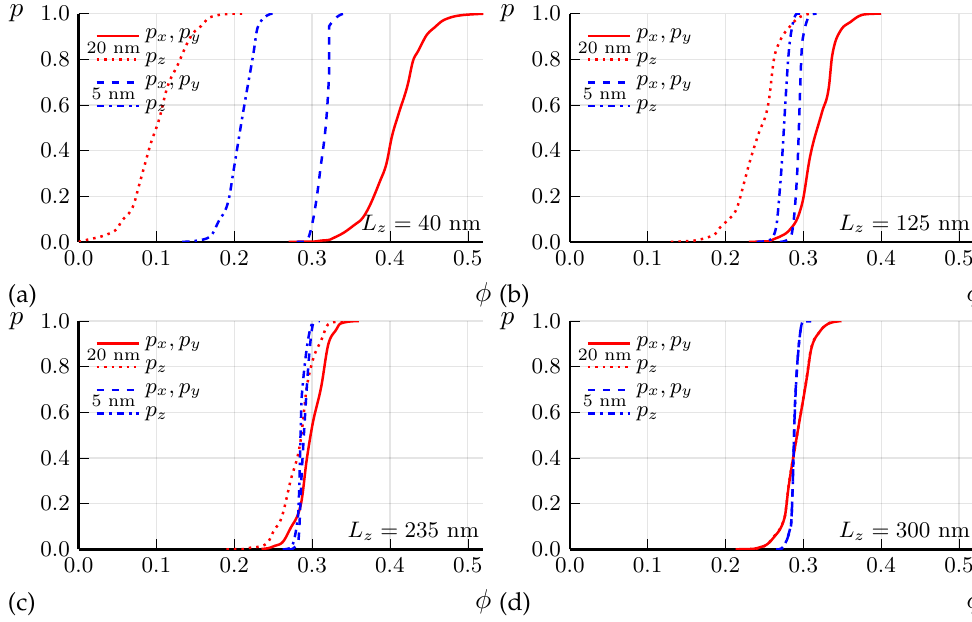
Figure 6. Probability p of current percolation along the in-plane x (red dashed curves) and the out-of- plane z axes (dotted blue curves) via SC domains of spheroid shape with aspect ratio a z / a x = 0.15 and height d z = 20 nm as a function of SC volume fraction φ in a sample of x - y area 2 × 2 µm 2 , calculated for four different sample thicknesses L z = 40 nm ( a ), L z = 125 nm ( b ), L z = 235 nm ( c ), and L z = 300 nm ( d ). The percolation probability is isotropic for L z = 300 nm. The current percolation and T c anisotropy in thin samples are very sensitive to the aspect ratio γ = a z / a x of SC domains, which allows its accurate measurement. Indeed, for the aspect ratio γ ≡ a z / a x = 0.12, as in Figure 5, the percolation threshold φ c is isotropic ( 2 ) ≈ 235 nm, but not for L ( 1 ) ≈ 300 nm, as in Figure 6 for for the sample thickness L z z slightly different γ = 0.15 and in our experiment. This suggests a new precise method for measuring the averaged aspect ratios d x : d y : d z of SC domains deep inside the sample, which is not accessible by STM or other surface measurements. Indeed, if small samples are fabricated, only several times larger than the expected domain size, then an anisotropic SC transition temperature T c to almost zero resistance should be observed, as in Figure 3. However, if the sample aspect ratios L x : L y : L z match the average aspect ratios d x : d y : d z of the SC domains, this T c anisotropy should disappear even if the sample size remains small, L i (cid:46) 10 d i , as for the sample with thickness L z = 300 nm and L x = L y = 2 µm in our experiment. The aspect ratios of this sample give the aspect ratios of the SC